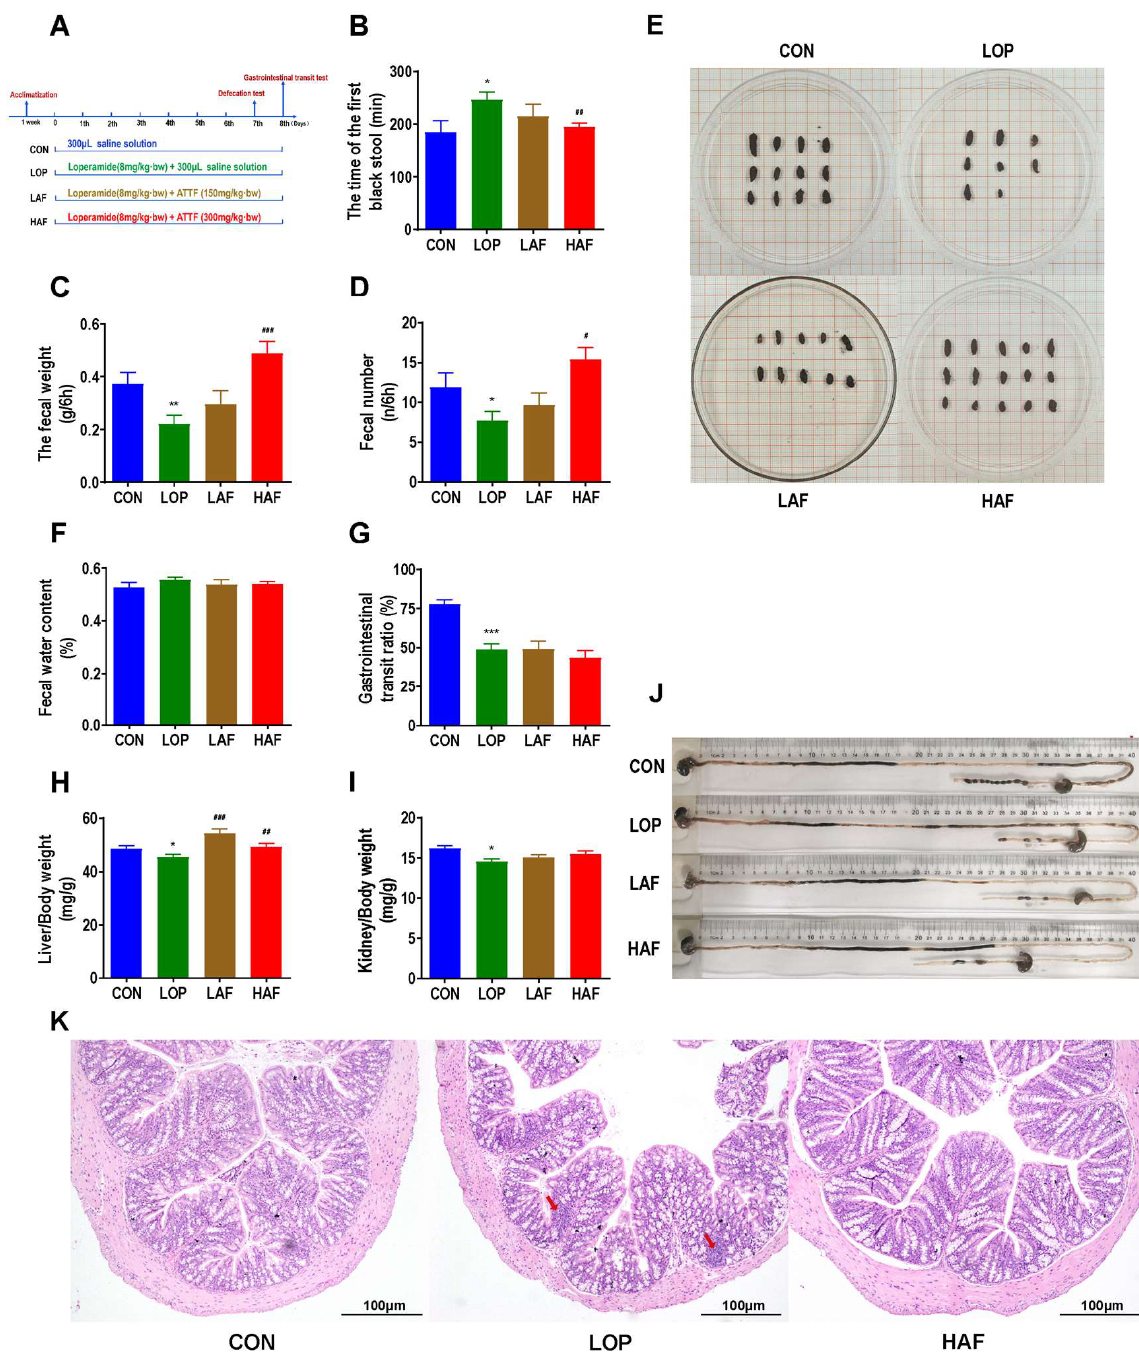
Figure 2. Influence of ATTF on loperamide-induced constipation symptoms in mice. ( A ) Grouping and basic workflow of animal experiment 4. ( B ) The defecation time of the first black stool, FBST. ( C ) Wet weight of feces excreted in 6 h, FW. ( D ) Number of feces excreted in 6 h, FN. ( E ) Representa- tive fecal morphology of each group. ( F ) Fecal water content. ( G ) Gastrointestinal transit rate, GTR. ( H ) Liver index. ( I ) Kidney index. ( J ) Ink advancing distance and intestinal length. ( K ) Photomicro- graphs of H&E-stained proximal colon sections. Infiltration of inflammatory cells into the tissue is shown in blue in the photomicrographs in the LOP group. The data are expressed as the means ± SEMs ( n = 10–12). *, **, ***, compared with the CON group; #, ##, ###, compared with the LOP group. *, p < 0.05; **, p < 0.01; ***, p < 0.001. #, p < 0.05; ##, p < 0.01; ###, p <